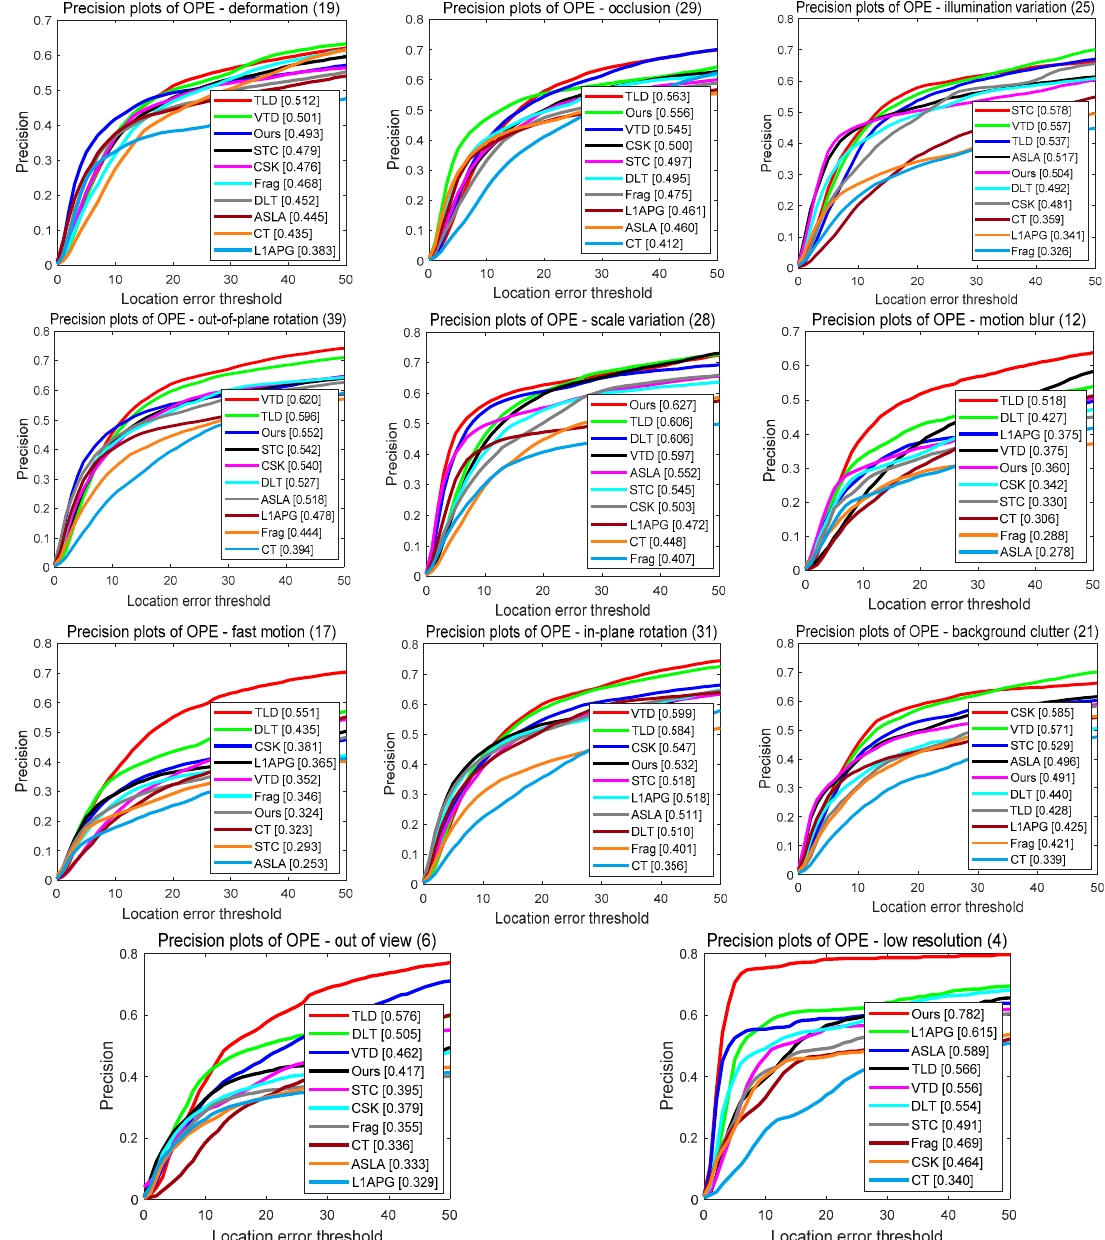
Figure 5. Precision plots for different attributes. The legend contains the precision score of each tracker at 20 pixels.